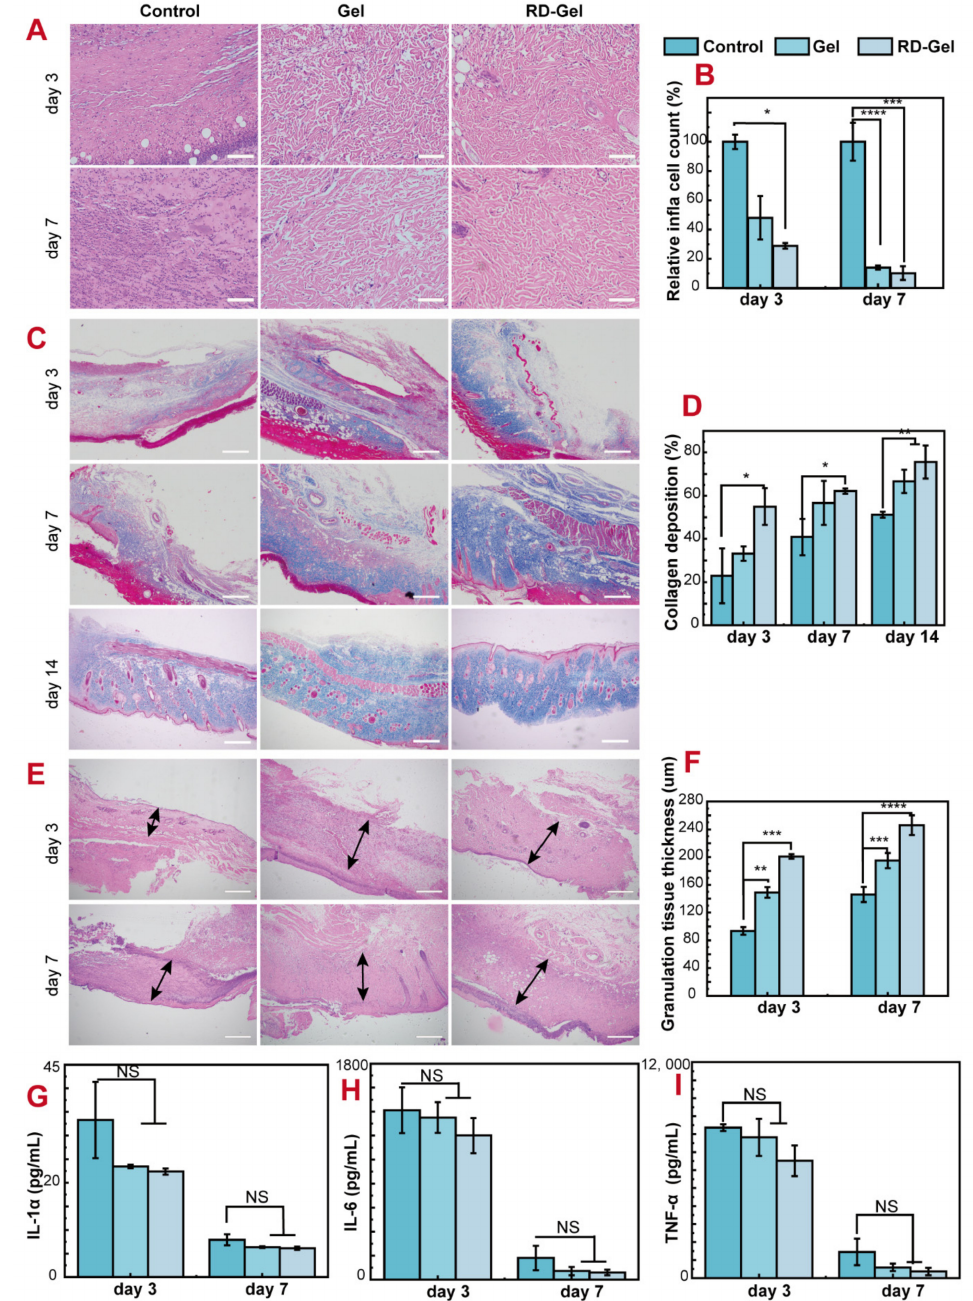
Figure 6. ( A ) H&E-stained images showing inflammatory cell infiltration in the wound area at 3 and 7 days after different treatments. Scale bar: 500 µ m. ( B ) Relative number of inflammatory